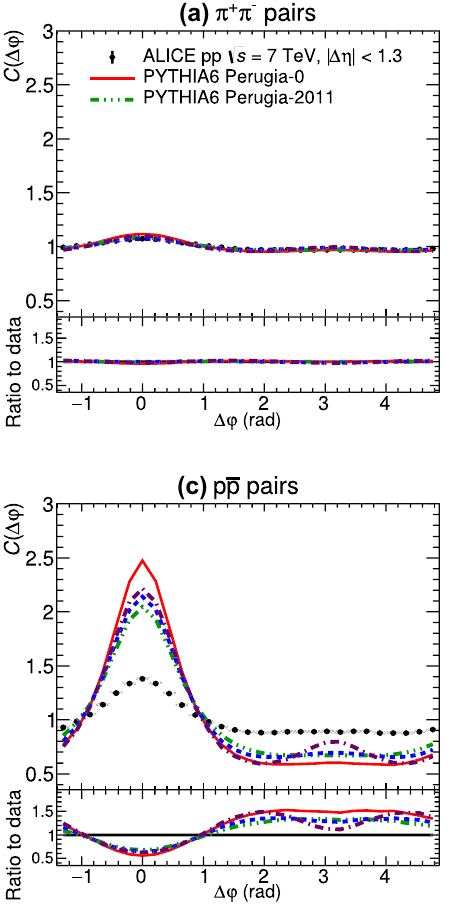
Fig. 5 (cid:3)η integrated projections of correlation functions for a π + π − , b K + K − , c pp, and d (cid:5)(cid:5) pairs obtained from ALICE data and four Monte Carlo models (PYTHIA6 Perugia-0, PYTHIA6 Perugia-2011,